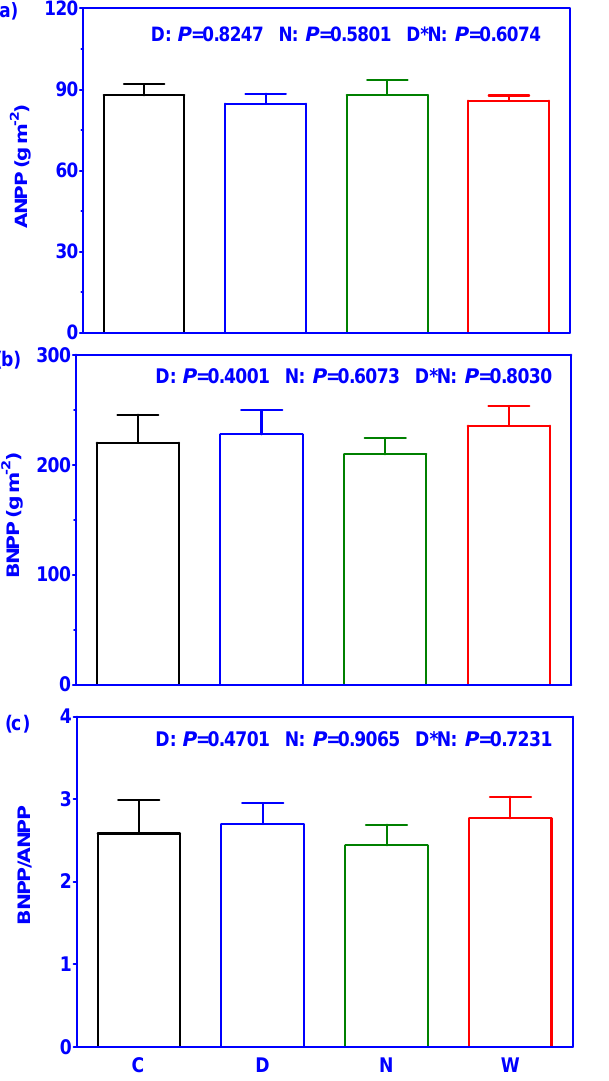
Fig. 5. Effect of different warming regimes (control C, day warming D, night warming N, and continuous warming W) on aboveground net primary productivity (ANPP) (a) , belowground net primary pro- ductivity (BNPP) (b) and the ratio of BNPP and ANPP (c) during the growing seasons of 2007–2009. The values of ANPP, BNPP and BNPP/ANPP were mean values of 2007–2009 from six plots with bars as standard errors.